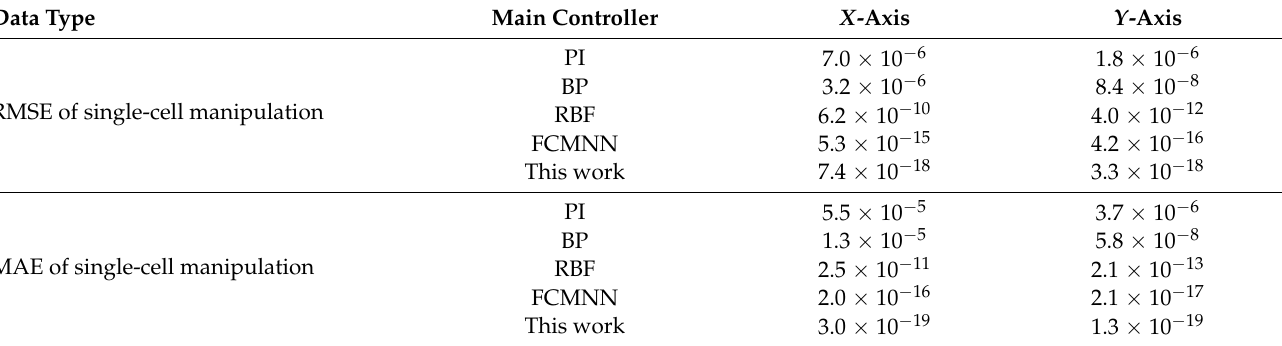
Figure 7. Trajectory error using different controllers (single-cell manipulation). Table 2. Root mean square error (RMSE) and mean absolute error (MAE) of single-cell